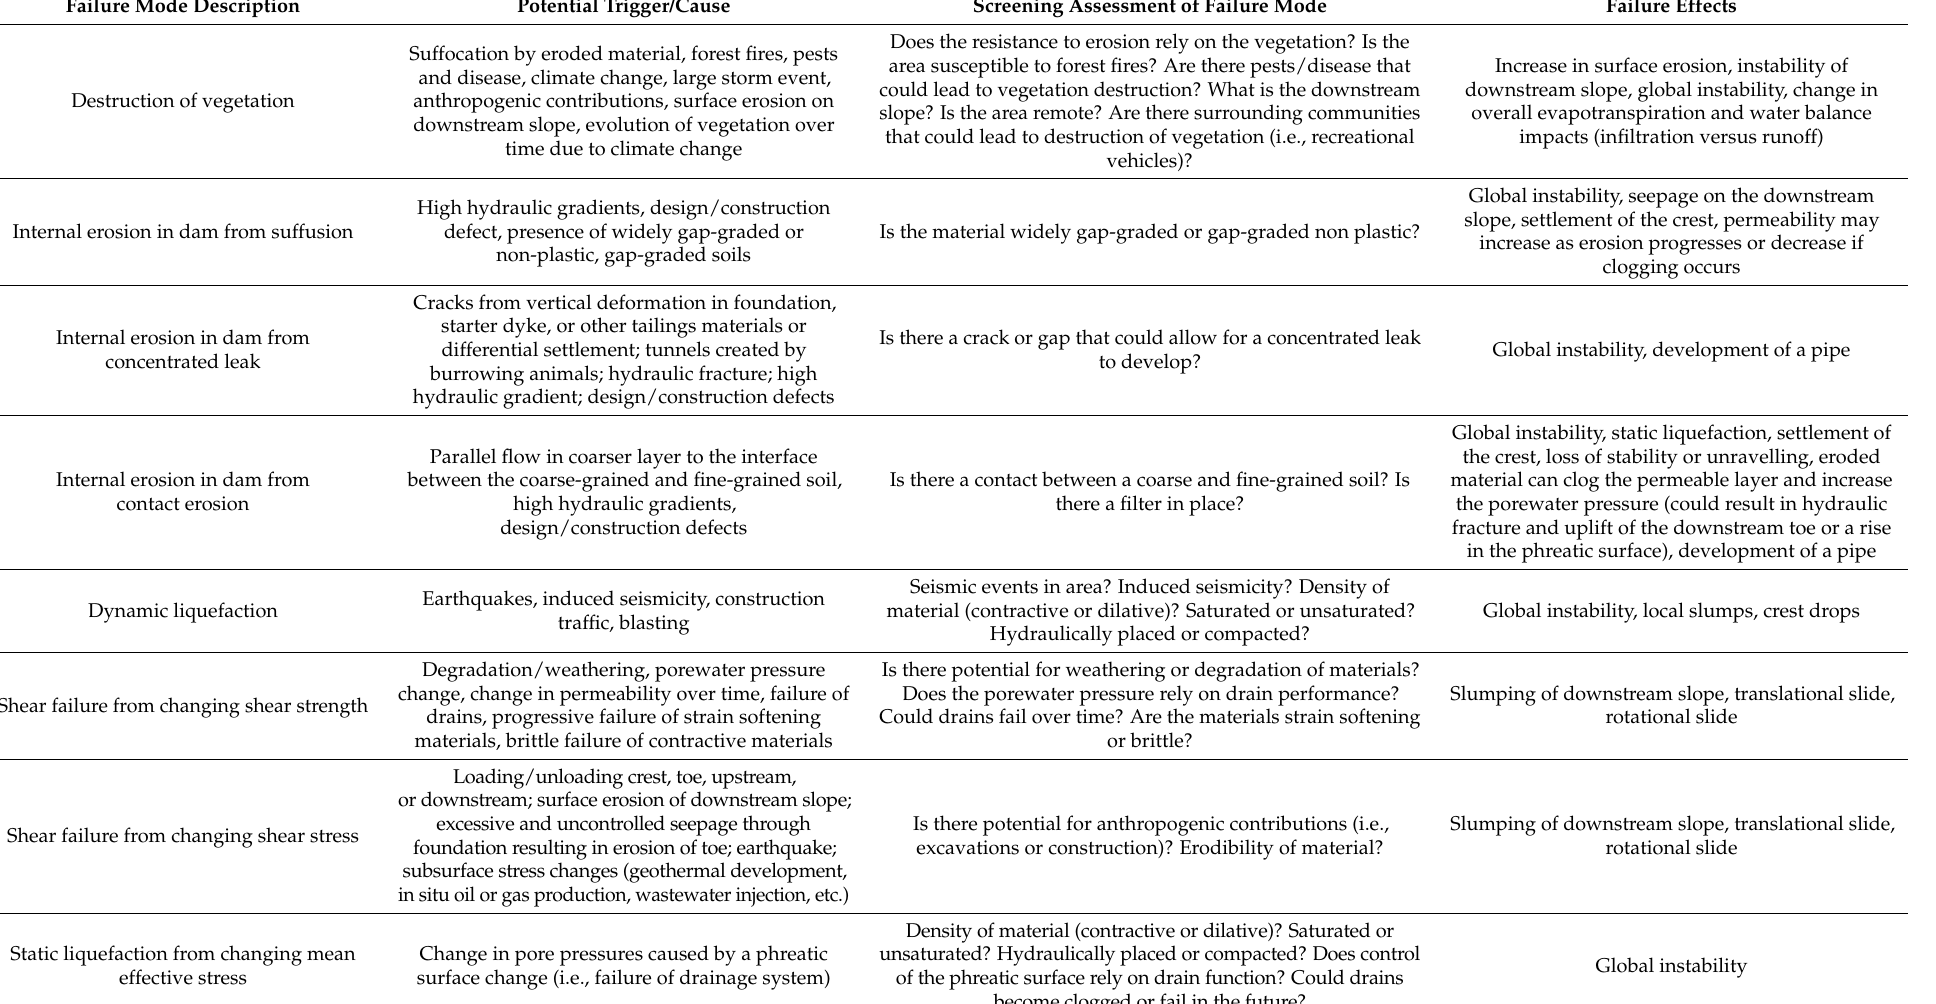
Table A3. Dam body